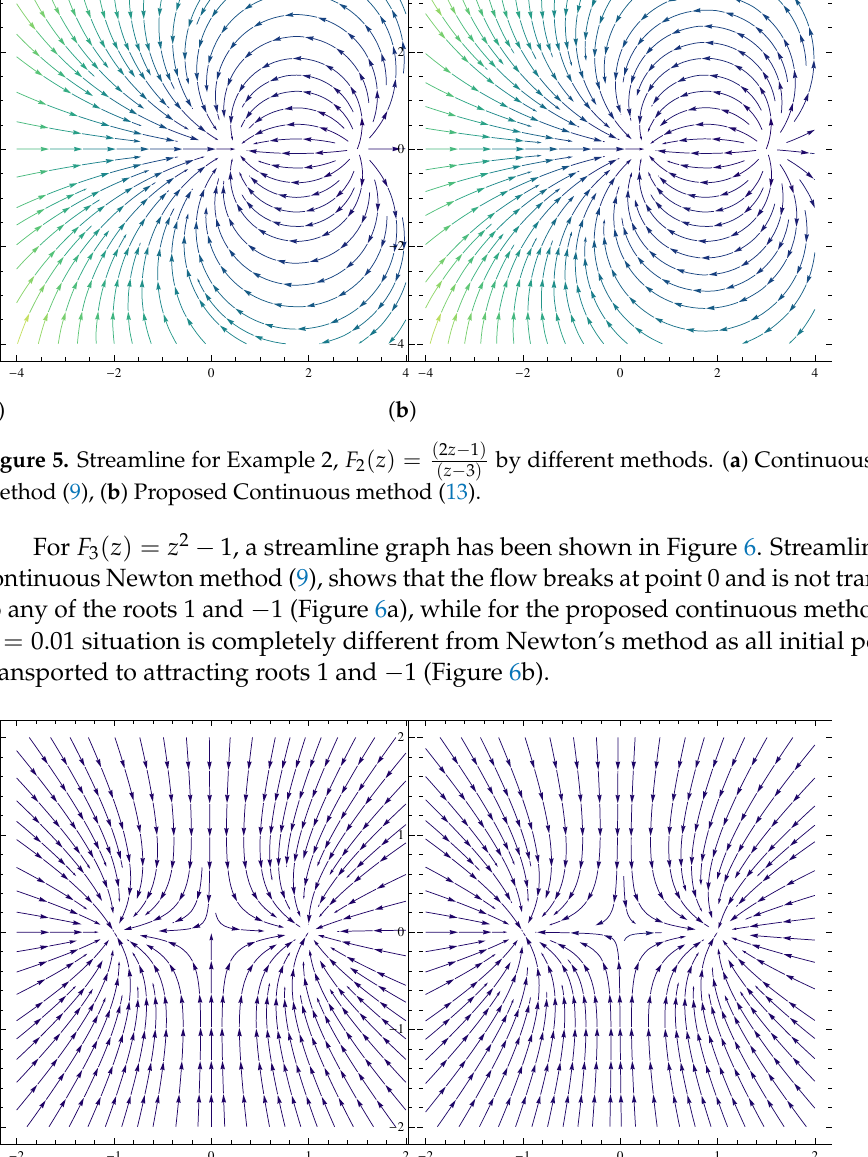
Figure 6. Streamline for F 3 ( z ) = z 2 − 1 by different methods. ( a ) Continuous Newton method (9), ( b ) Proposed Continuous method